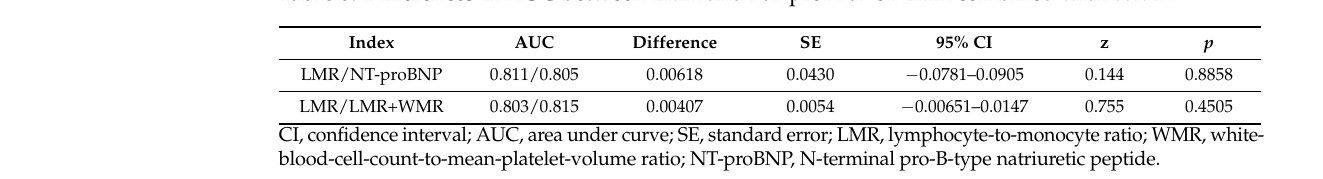
Table 8. Differences in AUC between LMR and NT-proBNP or LMR combined with WMR.